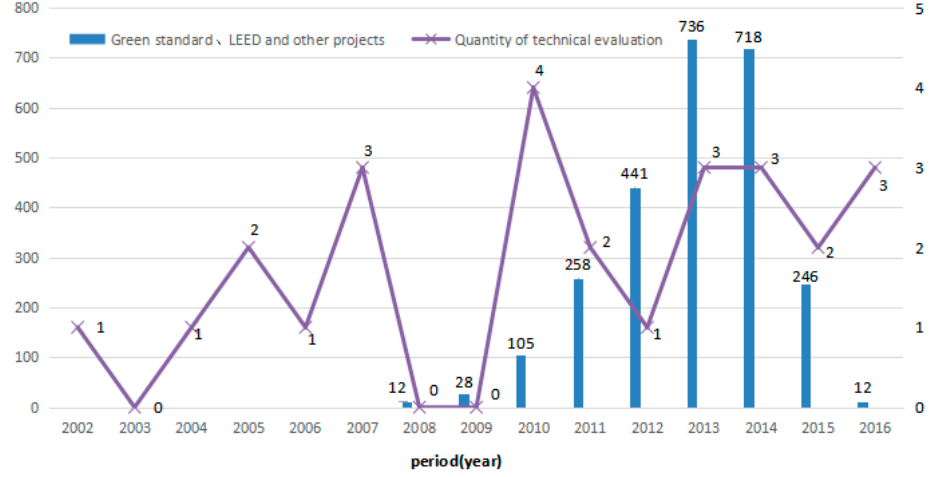
Figure 3. The number of star labelling projects in green building and technical evaluation standards in China from 2002 to 2016.